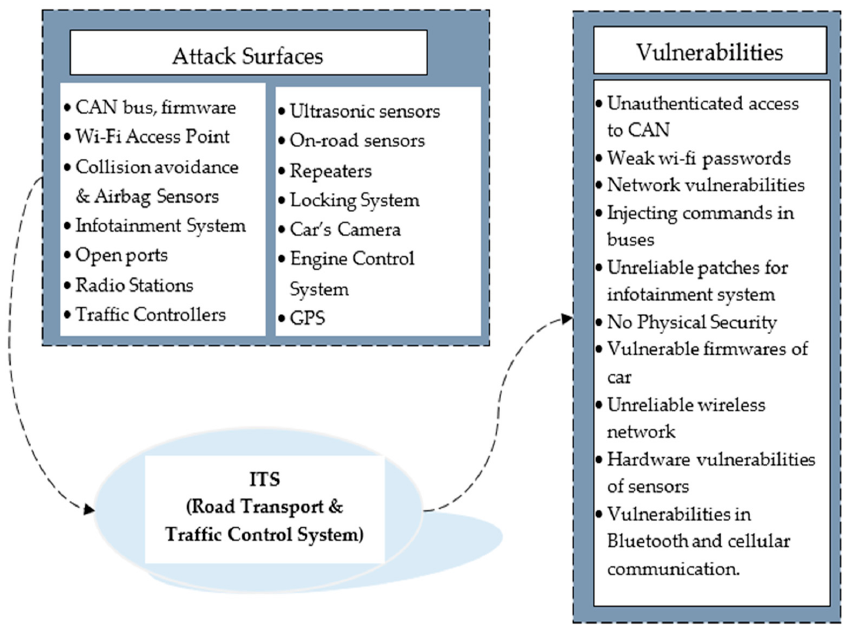
Figure 7. Attack Surfaces with known Vulnerabilities in ITS [53–57].